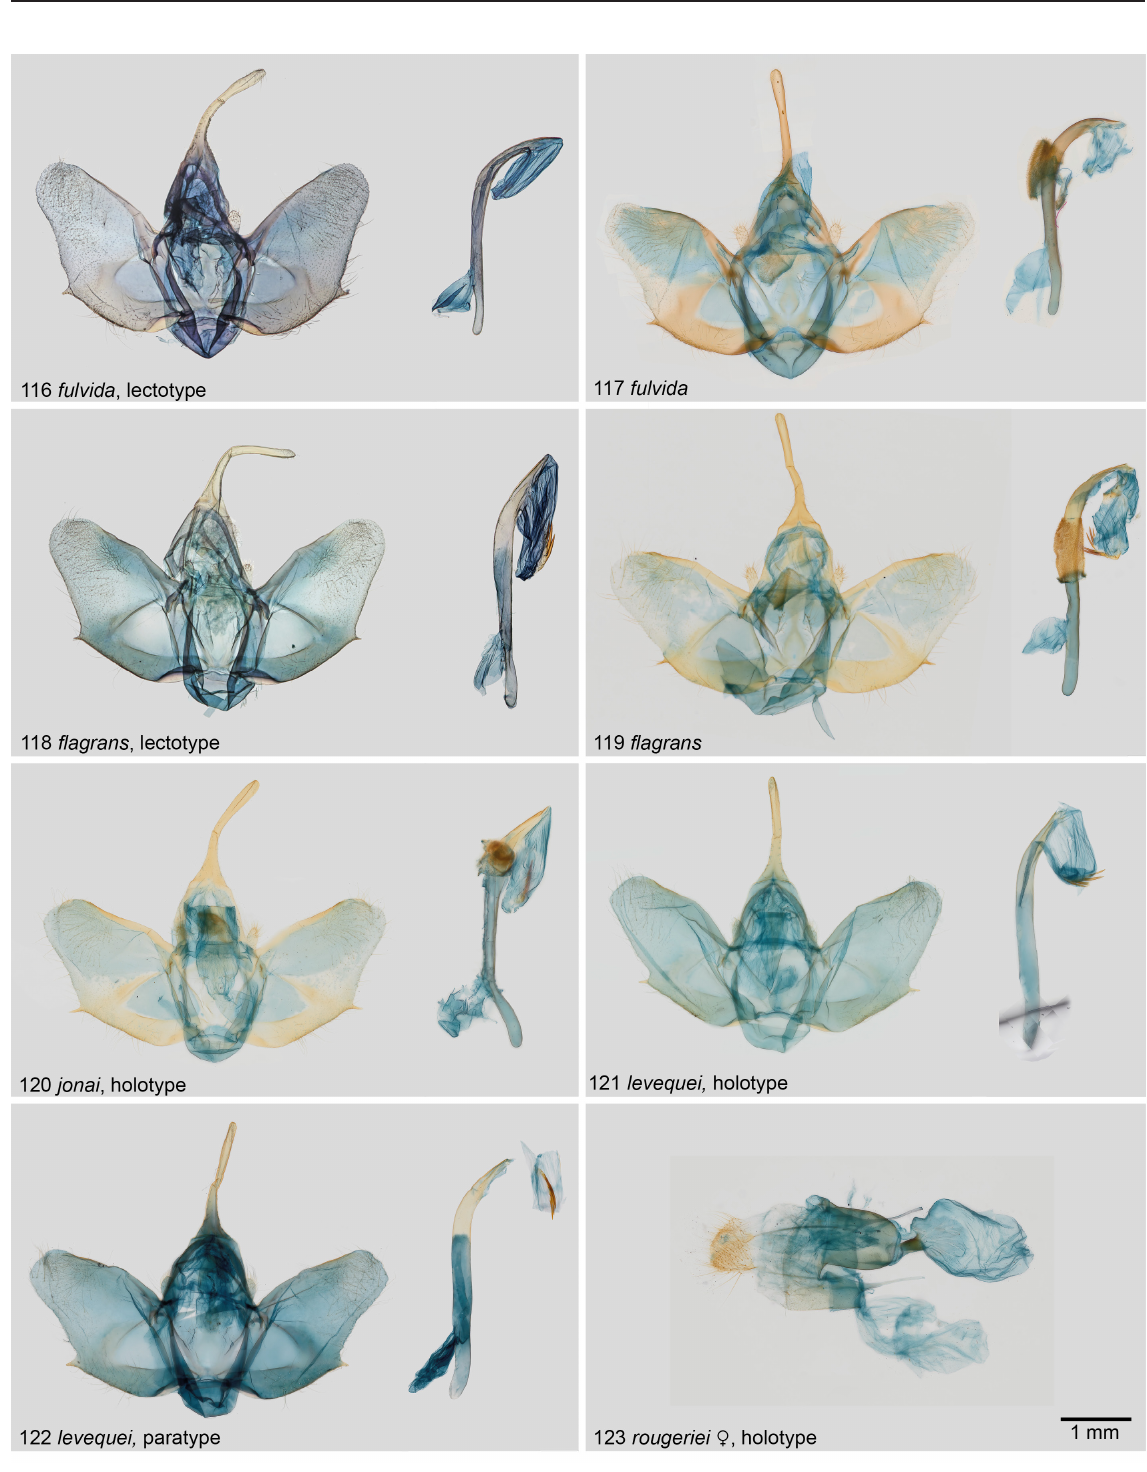
Figs 116–123. Male genitalia (left = valves; right = aedeagus) and female genitalia. 116 . Callipia fulvida Warren, 1907, ♂, lectotype (NHM). 117 . C. fulvida Warren, 1907, ♂ (C-0174, COI data). 118 . C. flagrans Warren, 1904, ♂, lectotype (NHM). 119 . C. flagrans Warren, 1904, ♂ (C-0022, COI data). 120 . C. jonai sp. nov., ♂, holotype (C-0020, COI data). 121 . C. levequei sp. nov., ♂, holotype (C-0073, COI data). 122 . C. levequei sp. nov., ♂, paratype (C-0072, COI data). 123 . C. rougeriei sp. nov., ♀, holotype (C- 0069, COI